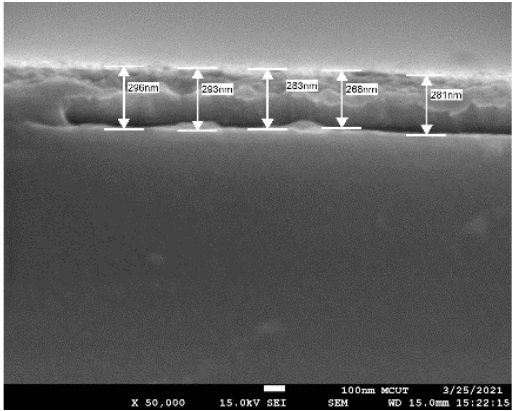
Figure 2. The FESEM cross-sections of the deposited silver layer to calculate the tooling factor.